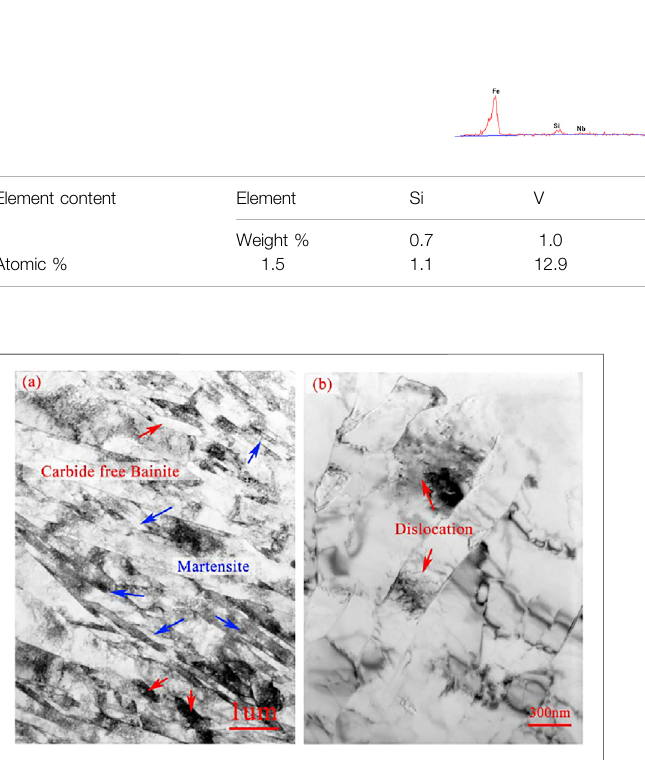
TABLE 4 | Characterization analysis of M 23 C 6 by EDS. Energy